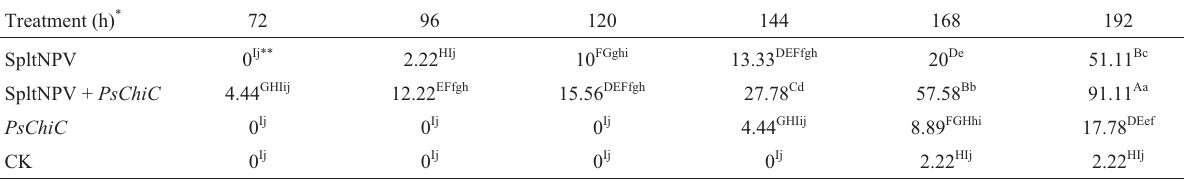
All data analyses were done using SPSS software. * Three replicates were done for each treatment and each replicate contained 30 larvae. ** Numbers indi- cate mortality rate (%), uppercase letters indicate p < 0.01 and lowercase letters indicate p < 0.05. SpltNPV - Spodoptera litura multicapsid nucleopolyhedrovirus.